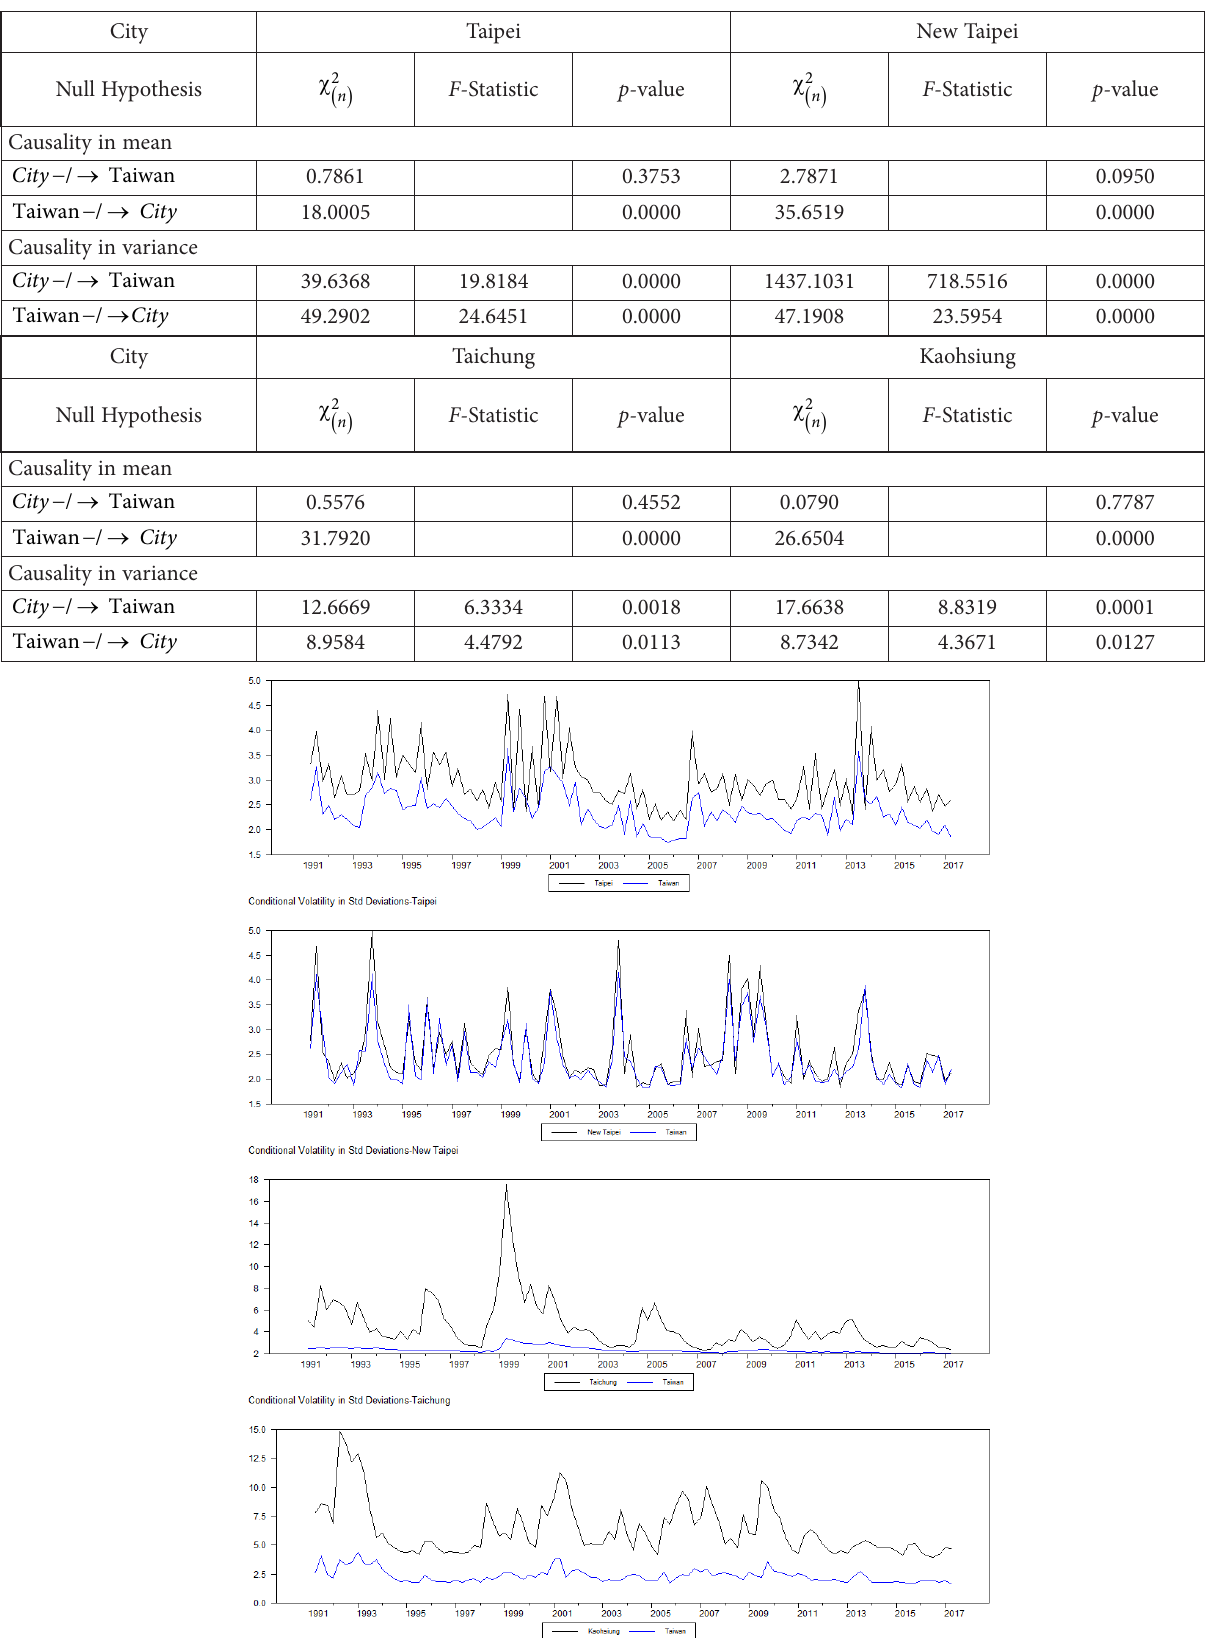
Table 4. Causality tests for the Taiwanese and the city’s housing markets City Taipei New Taipei